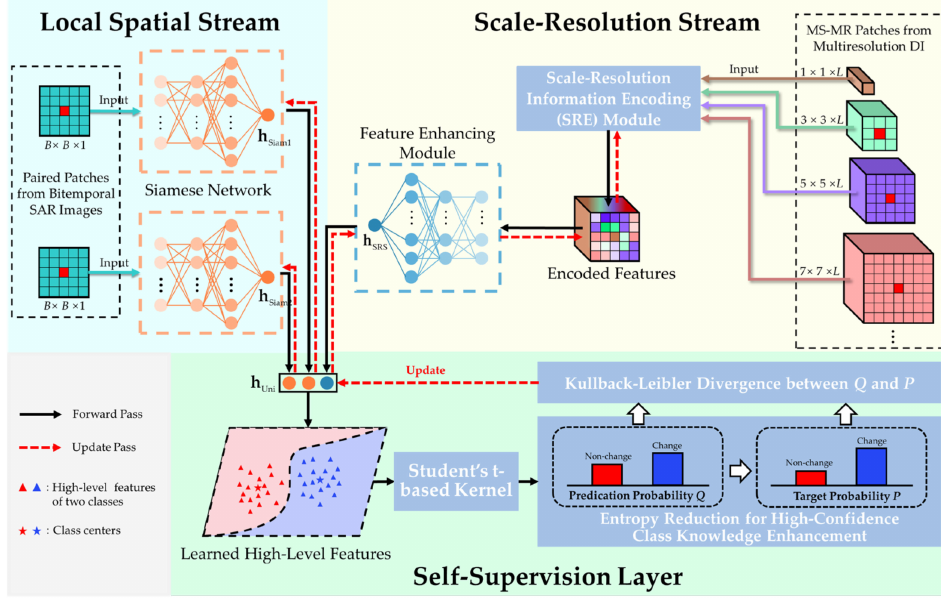
Figure 4. Framework of the proposed